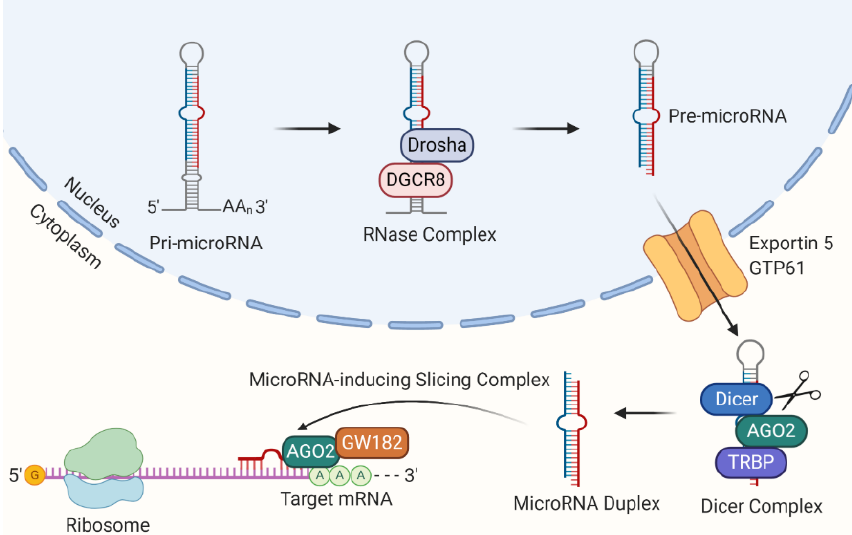
Figure 3. MicroRNA biogenesis. MicroRNAs are transcribed in the nucleus as pri-microRNAs. Pri- microRNAs are trimmed by Draosha-DGCR8 RNase complex and proceeded into pre-microRNAs that can be exported to the cytoplasm depending on the exportin 5/GTP61 translocation system. The Dicer complex binds to pre-microRNAs, which can be cleaved into microRNA duplexes containing guide and passenger strands. The guide strand often combines with AGO2 and GW182 as mi- croRNA-inducing slicing complex and then interacts with the target mRNA, leading to target trans- lation suppression or degradation. AGO2: argonaute 2; TRBP: transactivation response element RNA-binding protein.